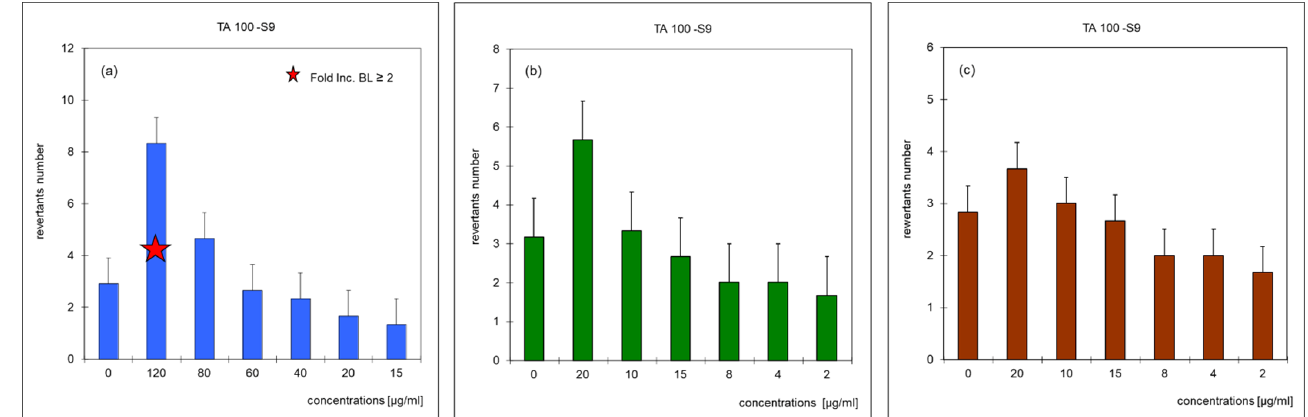
Figure 6. Influence of TPH, BTEX and PAHs concentration of the revertants number ( n = 3, p < 0.05):